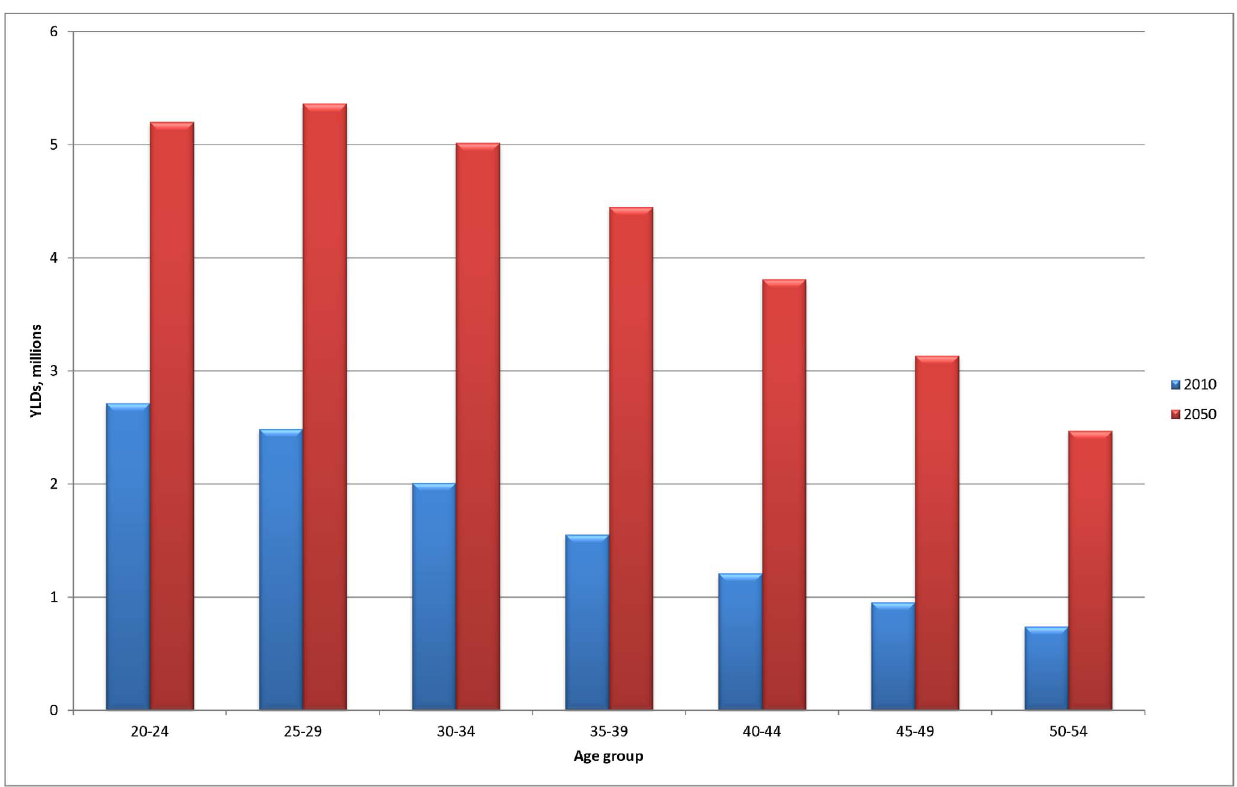
Figure 5. Change in disability burden of mental and substance use disorders over time, 20–54 years by age group, all Sub-Saharan